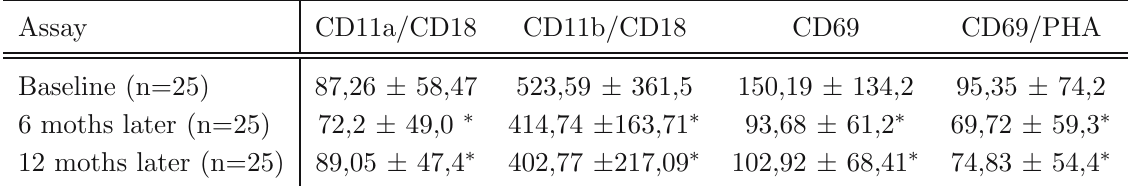
Table 1 Mean fluorescence intensity (MFI) in the study